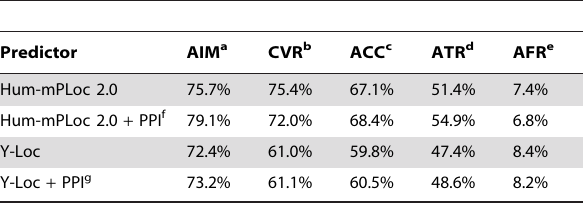
Table 2. Performance improvements for every single predictor.